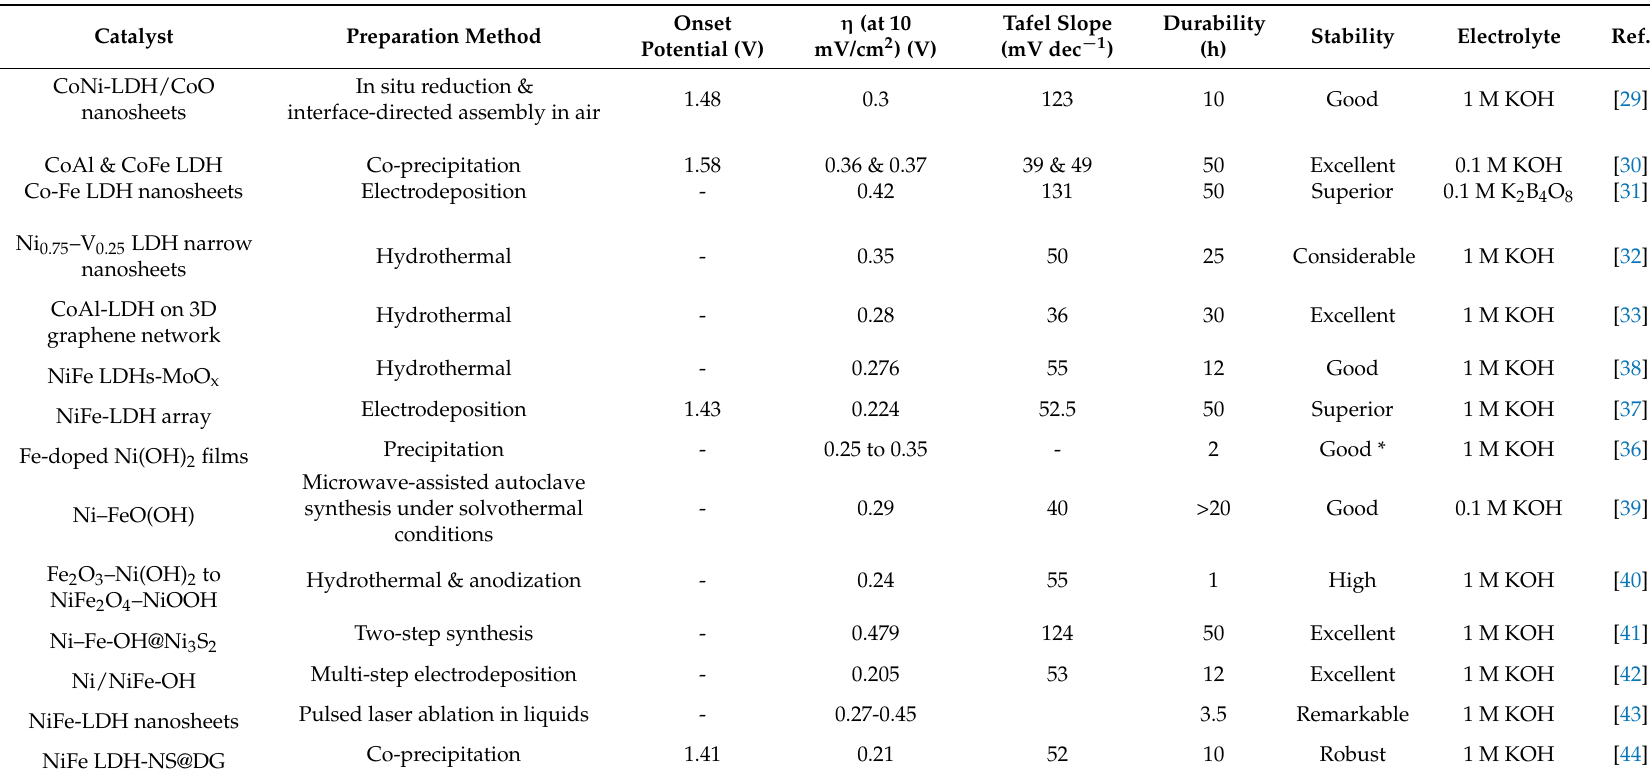
Table 2. Comparison of the electrocatalytic activity of noble metal-free LDH and related Ni–Fe catalysts (cf. Table 1 for definitions of “durability” and